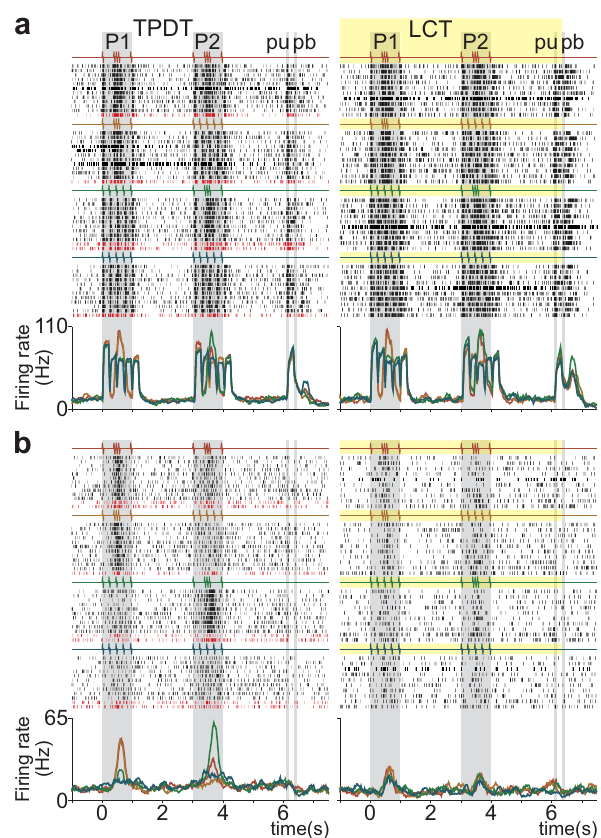
Fig. 2 Activity of single S2 neurons during the TPDT and LCT. a – b Raster plots of two additional S2 neurons tested in both tasks: the TPDT (left) and LCT (right). Only the TPDT trial rows are sorted by correct (black ticks) and incorrect (red ticks) trials for each of the four possible classes, individually. There were no errors during the LCT. Traces below the raster plots are class average fi ring rates per neuron and condition. Each color refers to one class: G-G (red); G-E (orange); E-G (green); and E-E (blue). Sensory responses endured during the TPDT and the LCT ( a ), while categorical responses ceased during the LCT ( b ). Intermediate neurons showed a mix between sensory-invariant and context-dependent categorical responses (see Supplementary Fig. 2).